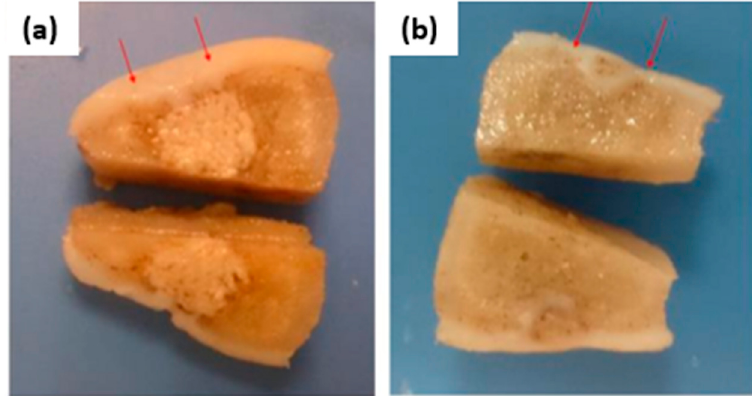
Figure 3. ( a ) Knee joint of the experimental group (biphasic composite scaffold implantation): The defect was filled with hyaline cartilage; subchondral bone was repaired, and non-degraded scaffold in the deep part of the femur condyle as well as bone tissue growth in the pores of the scaffold was noted. ( b ) Knee joint of the control group (without implants): The defect site was filled with hypertrophic cartilage-like tissue and invasion into subchondral bone area was observed.